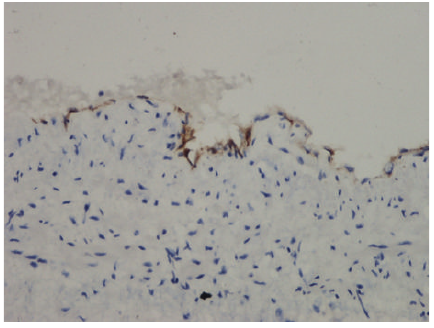
Figure 4: D2-40 immunostaining, DAB, ×